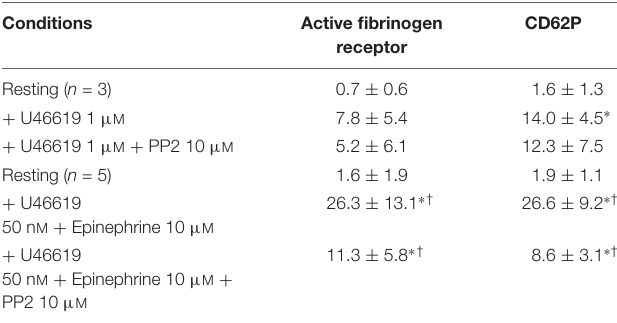
TABLE 1 | Effects of the Src-family inhibitor PP2 on the expression of P-Selectin (CD62) and the active form of the fibrinogen receptor, as assessed using the monoclonal antibody